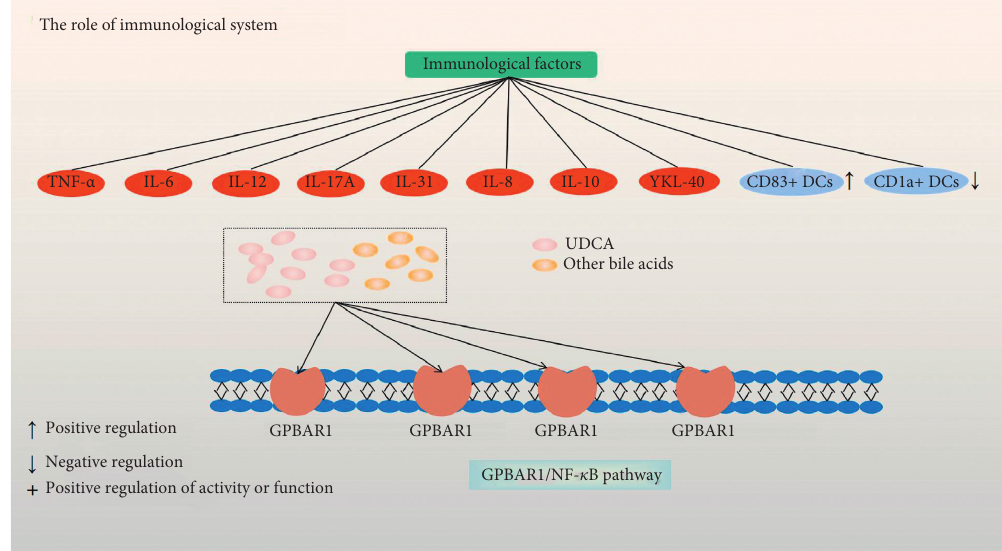
Figure 3: The role of inflammatory factors in the pathogenesis of ICP. The discovered ones include TNF- α , IL-6, IL-12, IL-17A, IL-31, IL-8, IL-10, and YKL-40, which are represented by red circles. In ICP patients, the number of DCs in the immune cell subgroup CD83+ is higher, while the number of DCs in CD1a+ is lower, indicated by blue circles. In addition, there is the GPBAR1/NF- κ B pathway, and UCDA can compete with other bile acids for the GPBAR1 receptor. Regulation events are displayed with arrows.